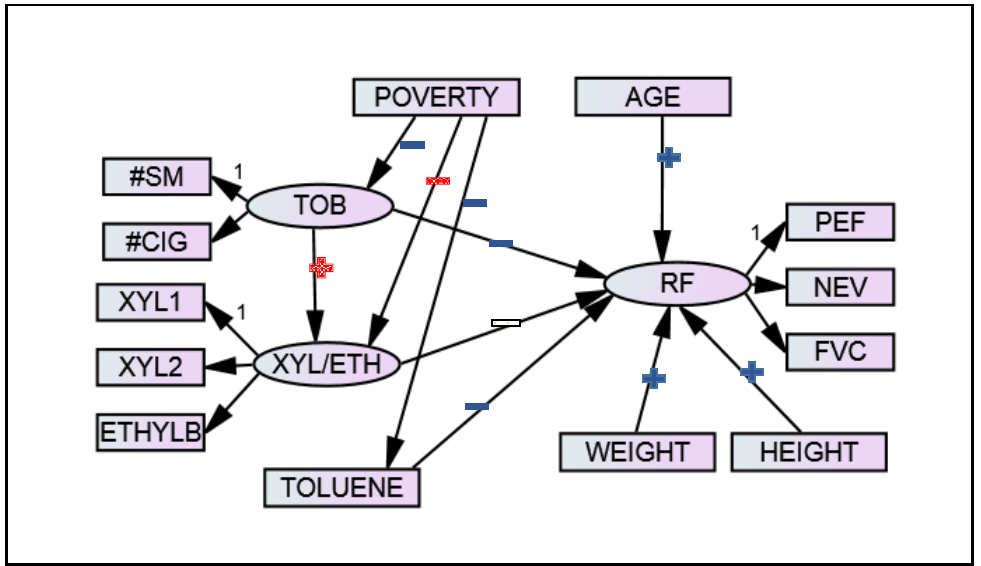
Figure 2. Final SEM of respiratory function, tobacco smoke exposure, and VOCs with significance and direction indicators. Plus signs indicate positive relationships and minus signs indicate negative relationships. Blue (solid) symbols are significant at the α = 0.05 level, white (unfilled) symbols are significant at the α = 0.15 level, and red (checkered) symbols are not significant at the 0.15 level. “1” identifies the observed variable within each latent variable whose factor loading was fixed to 1. Table 3. SEM of respiratory function, tobacco smoke exposure, and VOCs: estimates, standard errors, and p -values.